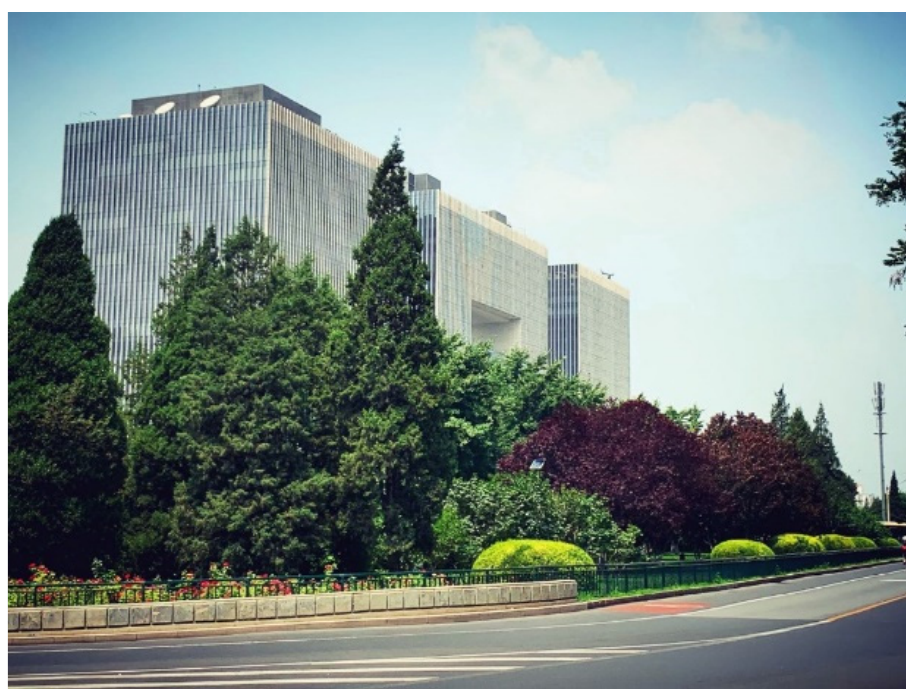
Figure 5. China Petroleum Tower (from Baidu Map).